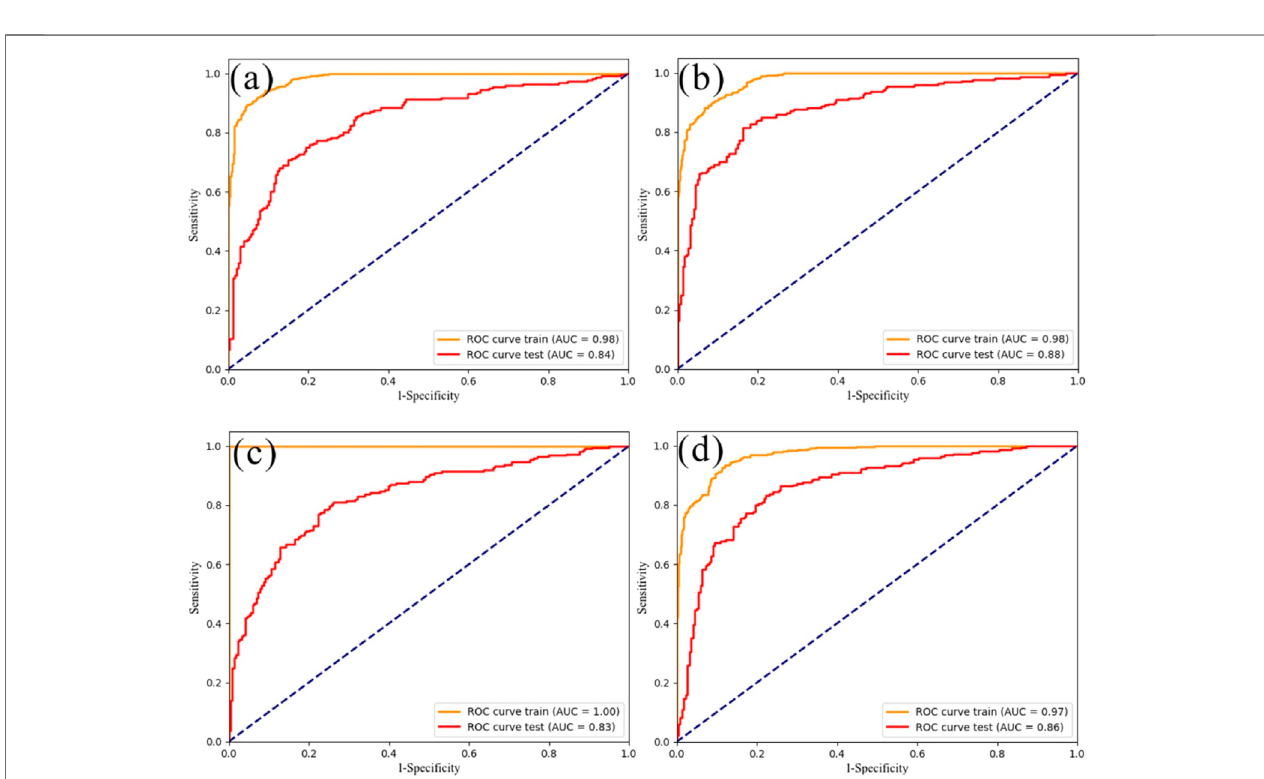
FIGURE 10 | ROC curves. the RF models (A) before and (B) after hyperparameter optimization; the XGBoost models (C) before and (D) after hyperparameter optimization.